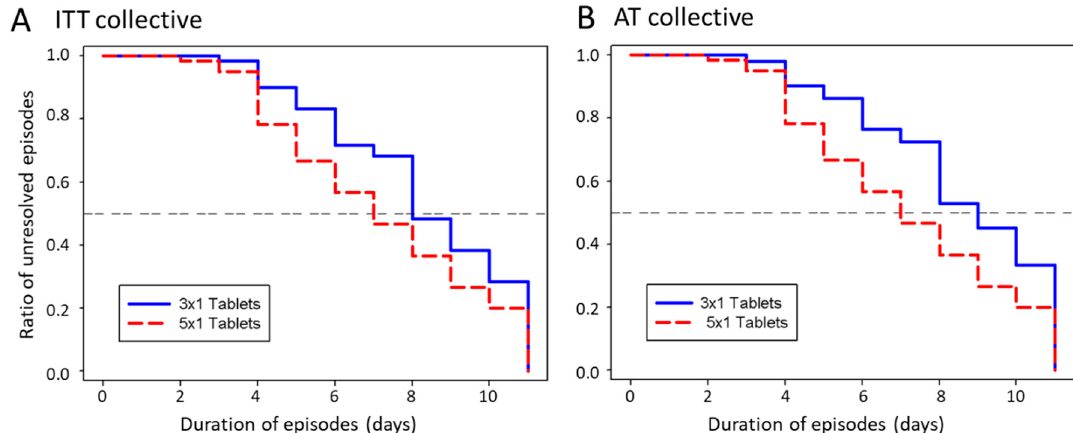
Figure 3. Kaplan–Meier estimate curves of the ratio of unresolved episodes per Echinaforce Junior Tablets (EFJ)-treatment day in the “intention-to-treat” (ITT) collective ( A ), and in the “as-treated” collective ( B ). The curves of high dosage group is indicated in red dashed lines and the curves of the low dosage group indicated in blue solid lines. The high-dose group in the “as-treated” collective includes five patients who were originally allocated to the low-dose group but who showed > 160% EFJ consumption. Table 2. Average overall episode duration and cumulative number of sick days per patient in cases where treatment was indicated for the intention-to-treat (ITT) and as-treated (AT) collectives. Daily Dosage Regimen Collective Parameter 3 × 1 EFJ 1 5 × 1 EFJ 1 Wilcoxon Test ( p Value) ITT 2 Number of cold episodes 61 CSD 4 per study group, days ± SD